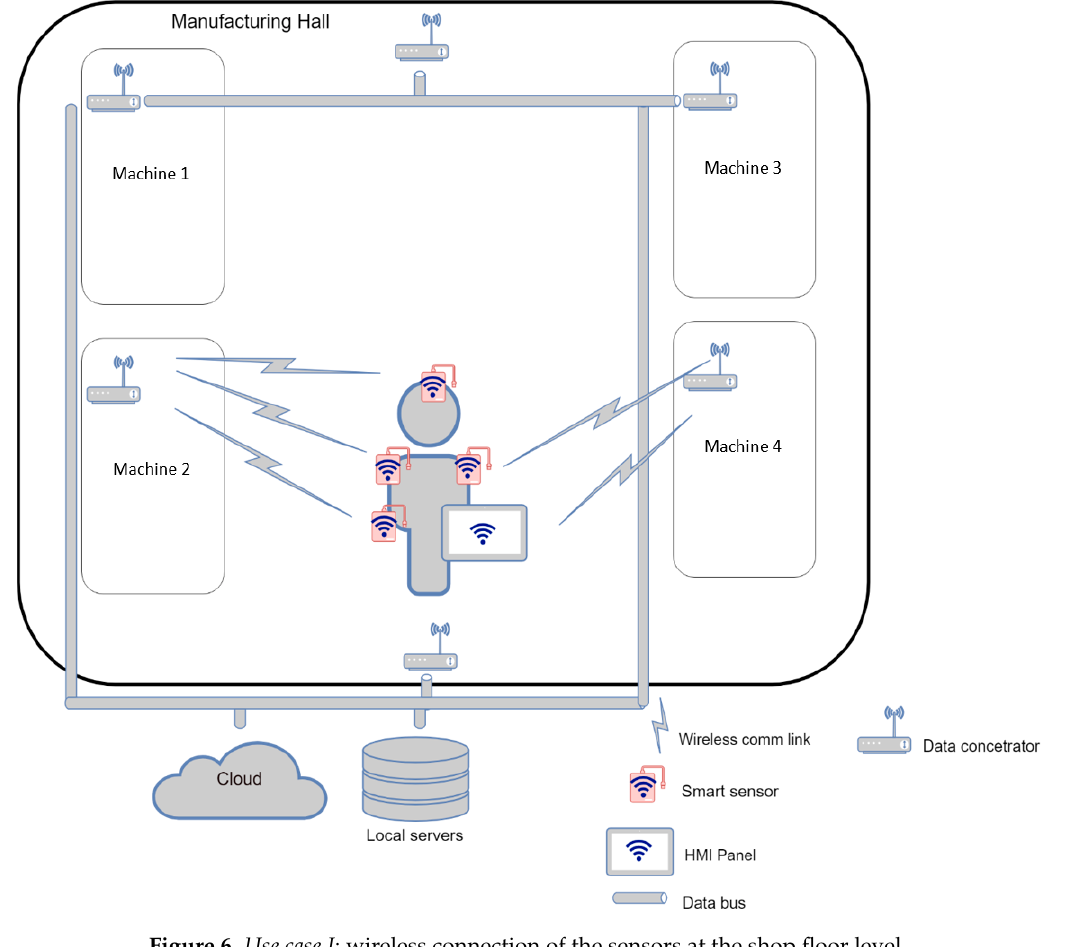
Figure 6. Use case I : wireless connection of the sensors at the shop floor level.